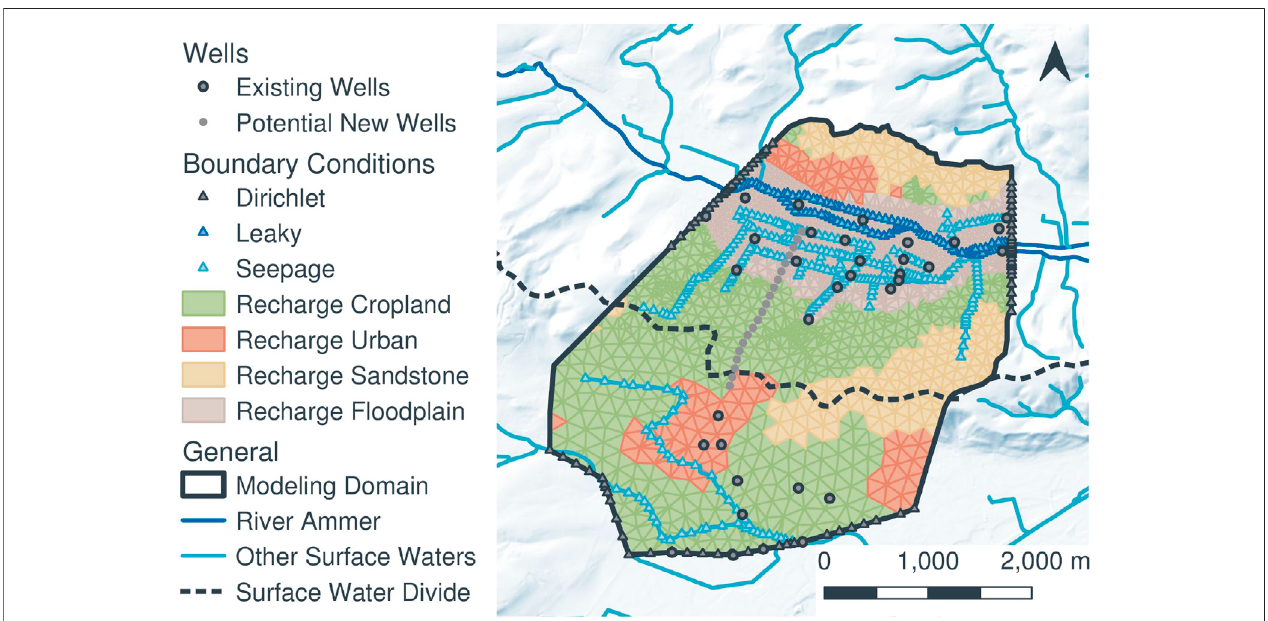
FIGURE 5 | Boundary conditions and two-dimensional discretization of the underlying subsurface fl ow model.